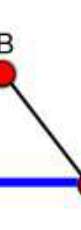
Fig. 3. Example of a Simmelian